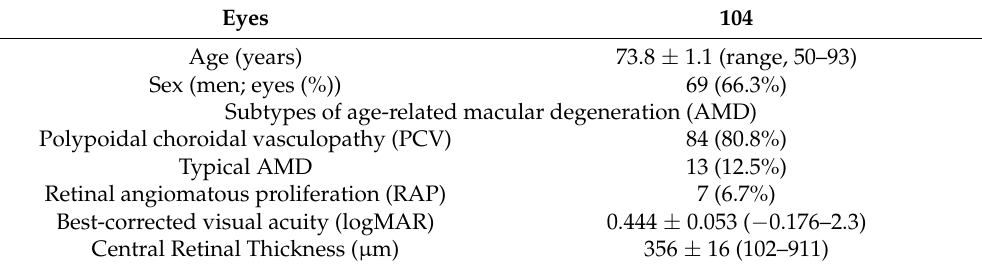
Table 1. Baseline